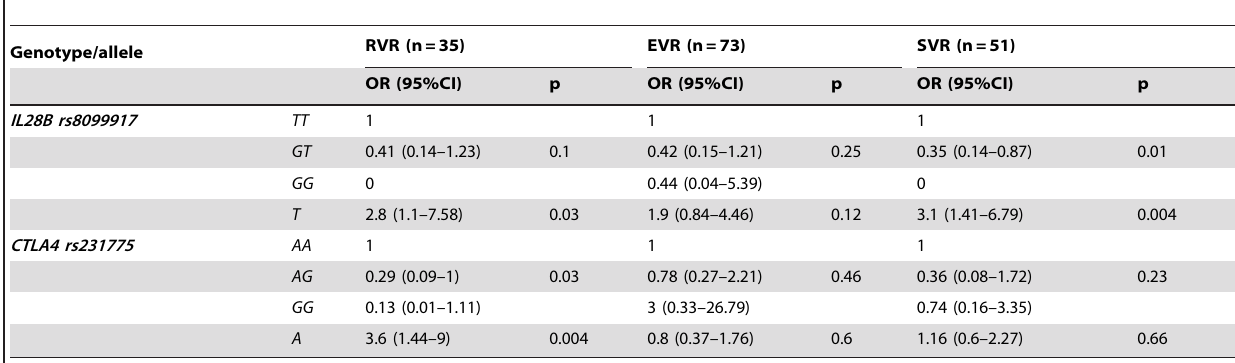
Table 3. Association between the different types of virological response and the genetic variants assessed.